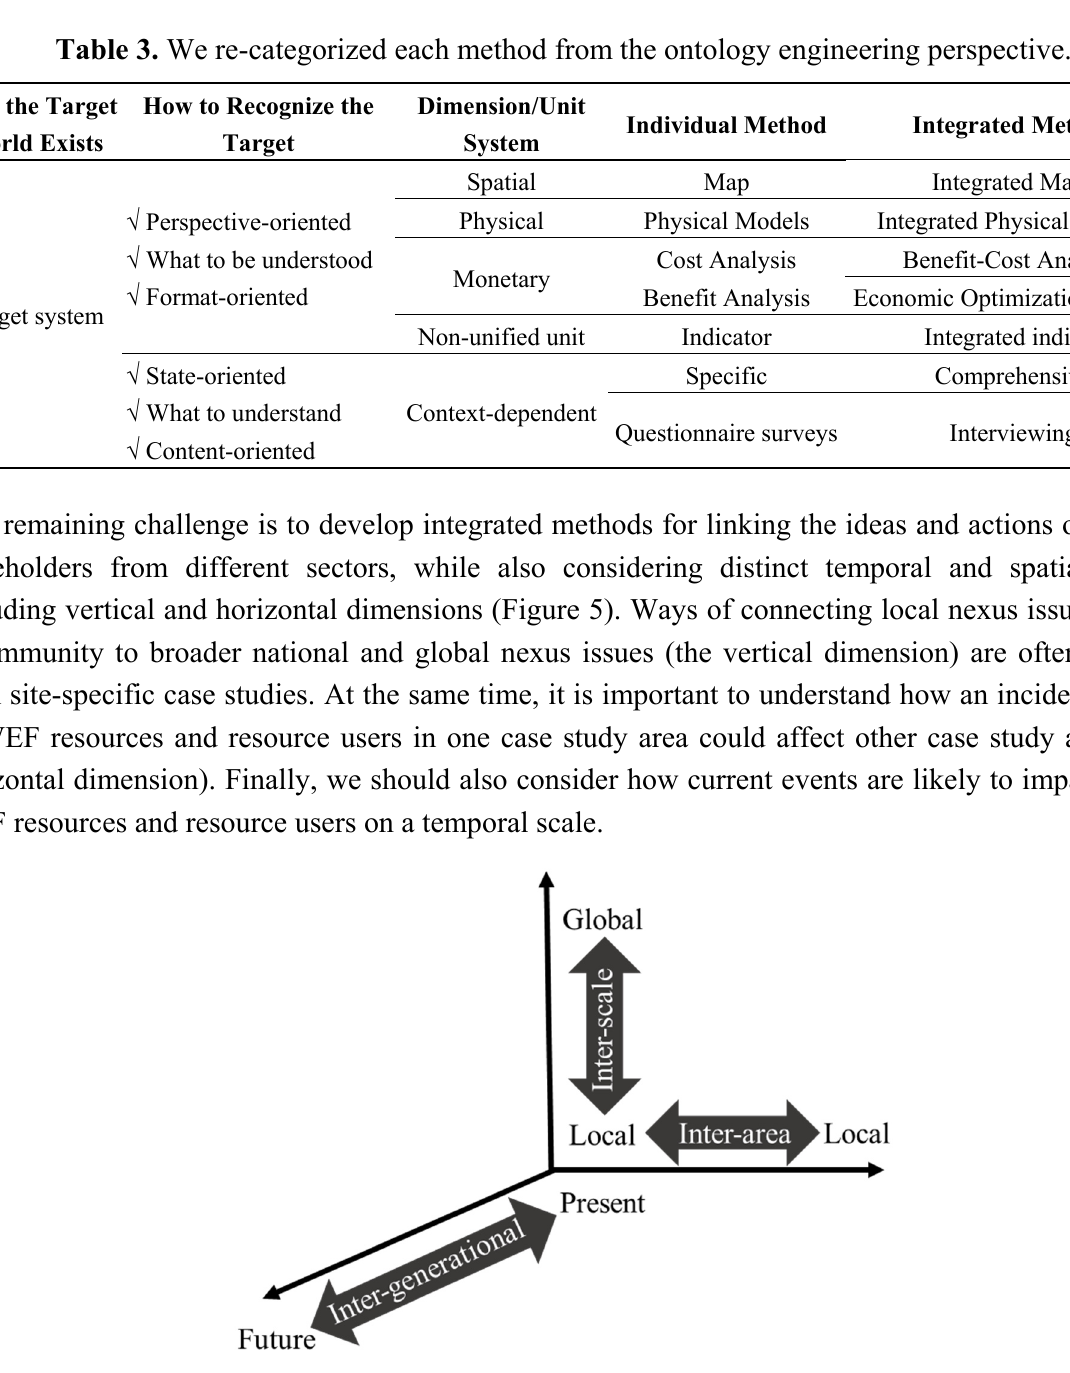
Figure 5. Relationships between targets on different spatial and temporal